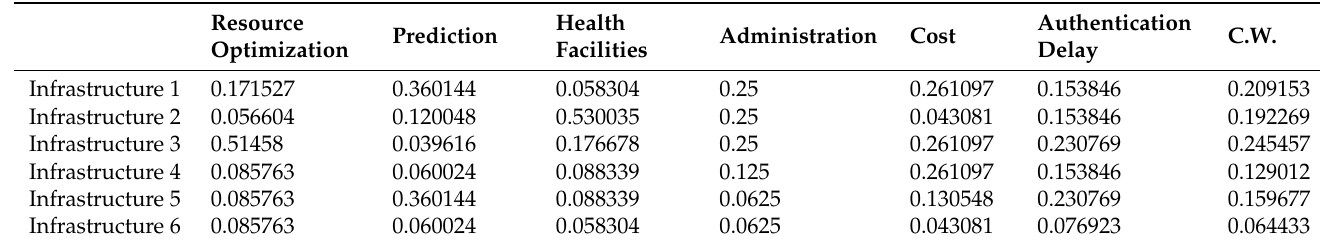
Table 5. Criteria